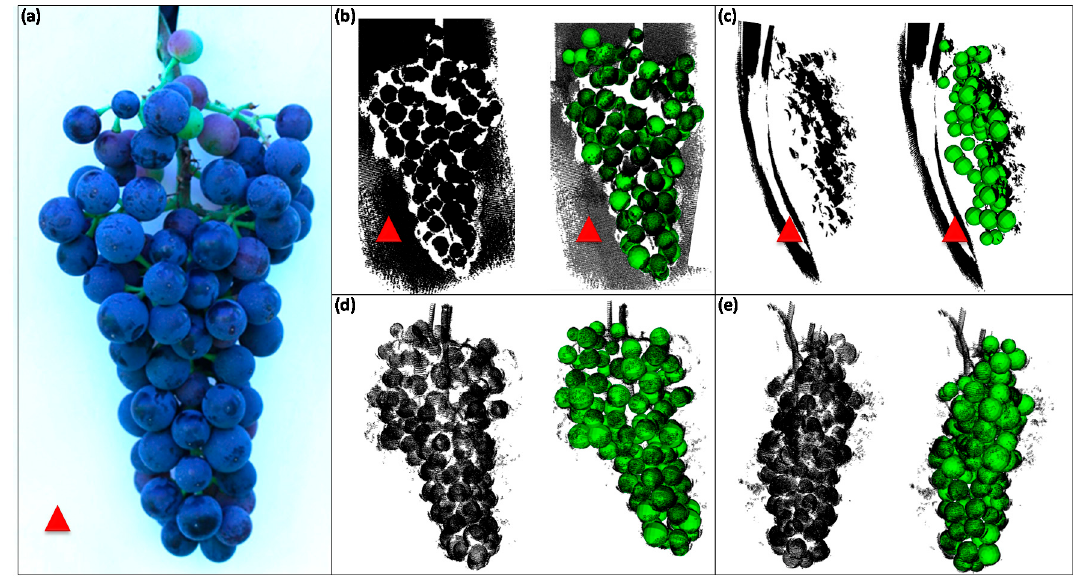
Figure 6. Application of the phenotyping pipeline in the field. Grape bunch of cultivar Dornfelder was prepared for scanning with artificial background ( a ). Front view of raw (left) and analyzed (right) 3D point cloud ( b ). Side view of the raw (left) and analyzed (right) 3D point cloud ( c ). Front view of the corresponding 360° scan from the point cloud in the lab. Raw (left) and analyzed (right) ( d ) 3D point cloud. Side view of the corresponding 360° point cloud. Raw (left) and analyzed (right) 3D point cloud ( e ). Red arrow heads mark the artificial background of partial point clouds.